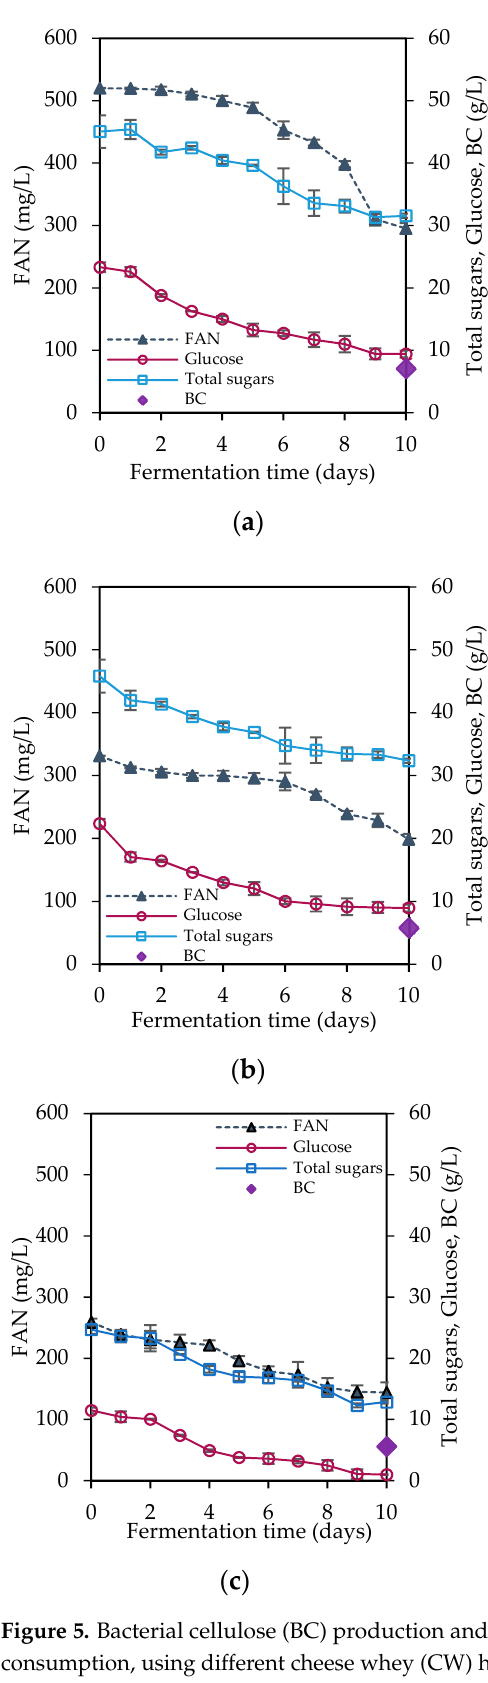
Figure 5. Bacterial cellulose (BC) production and kinetics of sugars and free amino nitrogen (FAN) consumption, using different cheese whey (CW) hydrolysates. ( a ) Hydrolysate A; ( b ) Hydrolysate B; ( c ) Hydrolysate C.